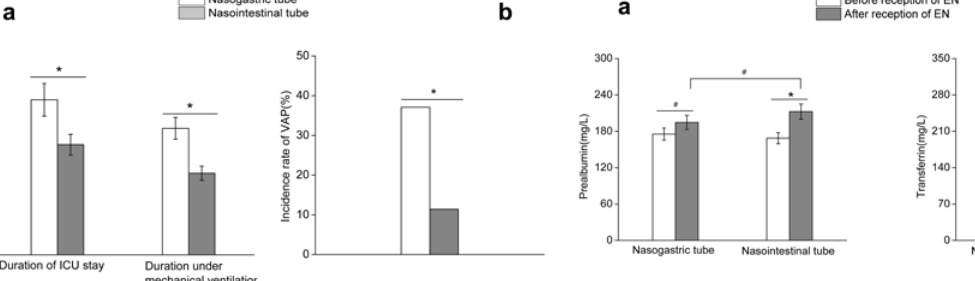
Figure 2: The level of prealbumin and transferrin increased in both groups after the administration of enteral nutrition. There was an increase in the levels of prealbumin and transferrin in the nasointes- tinal tube group(Fig 2a). However, there were no obvious difference in the nasogastric tube group (Fig 2b).